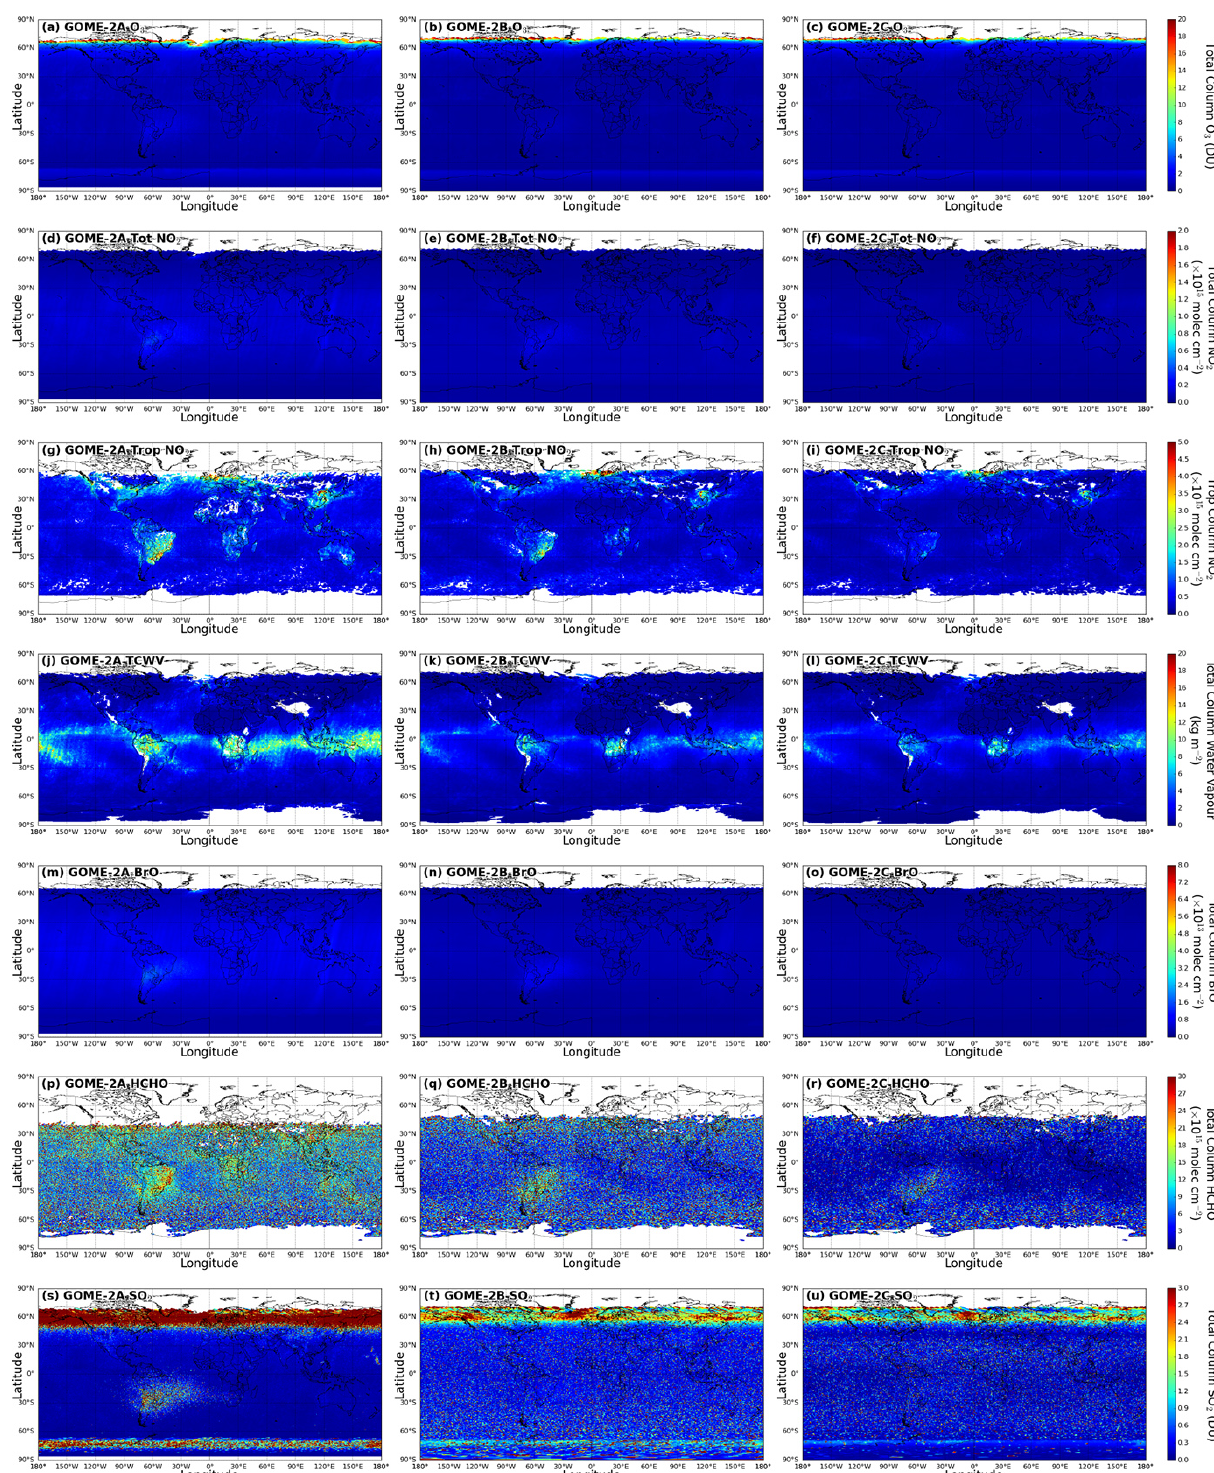
Figure 7. Derived measurement errors in the monthly level-3 product of GOME-2A (first column), GOME-2B (second column), and GOME- 2C (third column) for January 2020. Measurement errors of total column O 3 (first row), total column NO 2 (second row), tropospheric column NO 2 (third row), total column water vapour (fourth row), total column BrO (fifth row), total column HCHO (sixth row), and total column SO 2 (seventh row) are